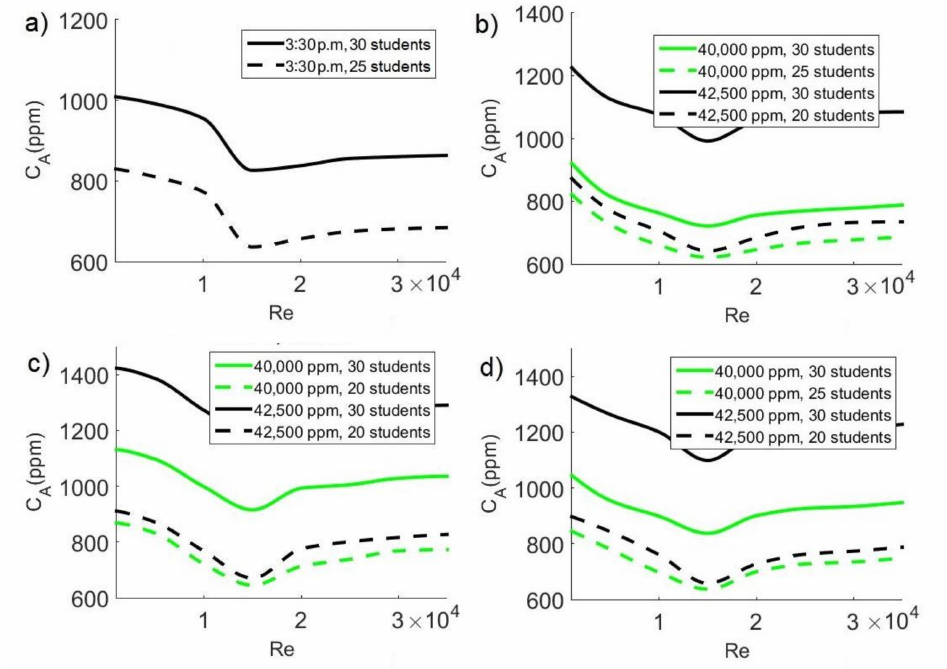
Figure 14. Reduction of the number of students to reach safe levels of CO 2 concentration (C A < 700 ppm) inside the classroom: ( a ) case III with Cs = 37500 ppm; ( b ) case III for 11:30 a.m.; ( c ) case III for 3:30 p.m.; ( d ) case III for 6:30